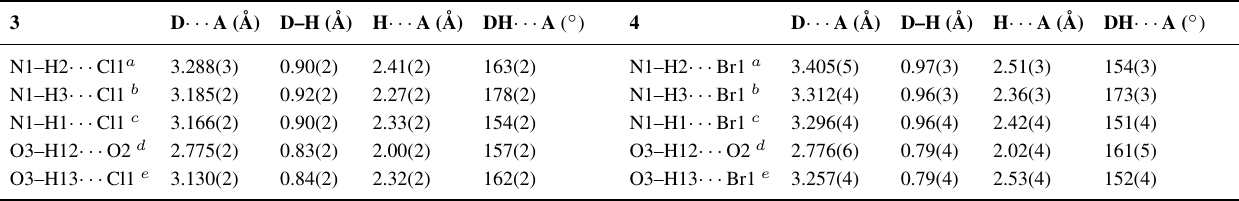
Table 5. Hydrogen bond geometry in 3 and 4